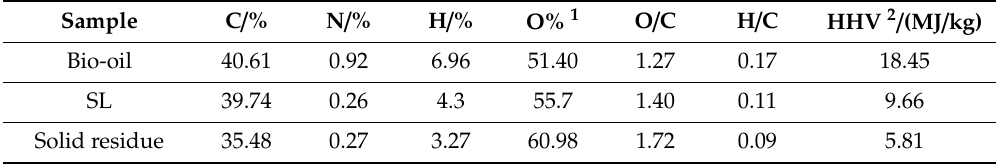
Table 2. Elemental analysis of bio-oil, SL and solid residue.